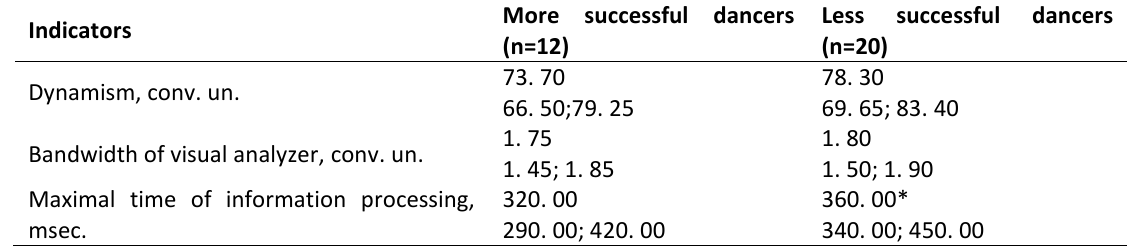
More successful dancers (n=12)